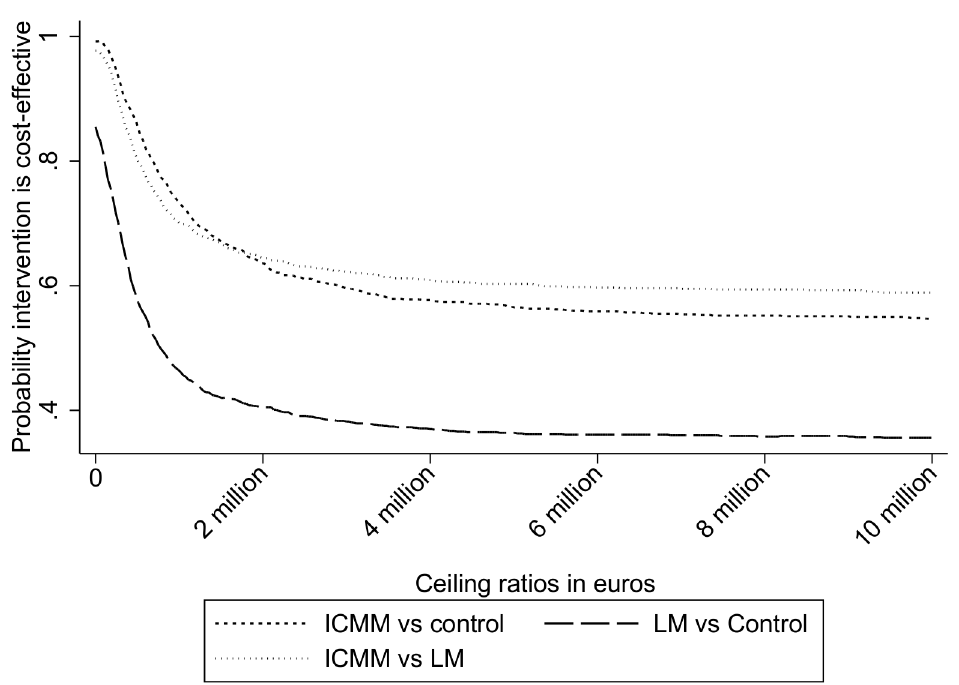
Fig 4. Cost acceptability curves for combined informal caregiver-person with dementia QALY for Intensive case management, the linkage and control model. Cost-effectiveness curves for all pairwise comparisons for the combined QALY of the person with dementia and informal caregiver. The long dash represented the comparisons between LM versus control group. The short dash compared the cost- effectiveness of the ICMM versus Control group. Dots were used to represent the comparison of the ICMM compared to LM. The threshold value used was 30,000 euros per QALY.